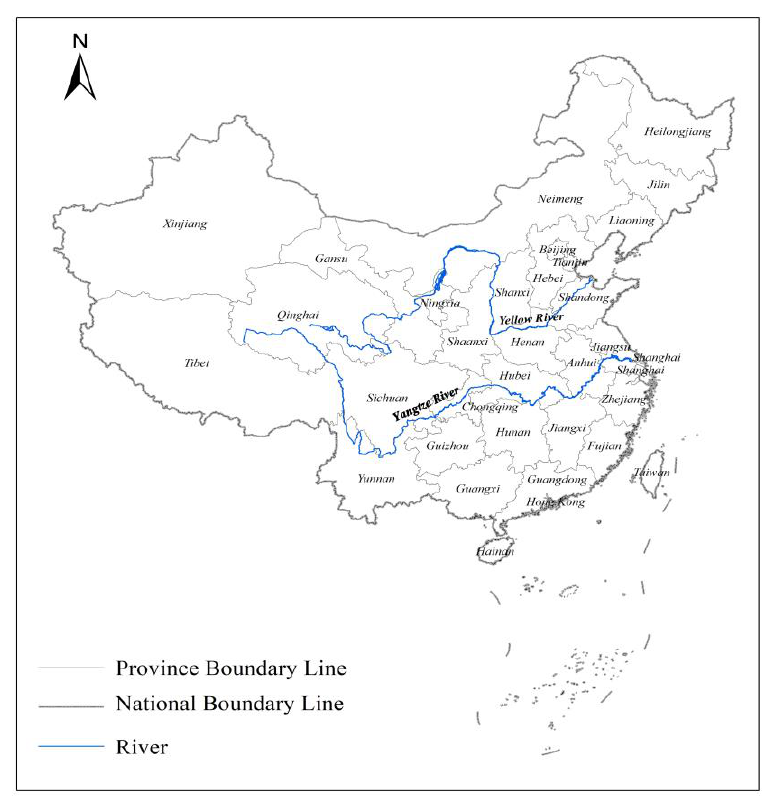
Figure 1. Map of Chinese provincial-level administration regionalization.